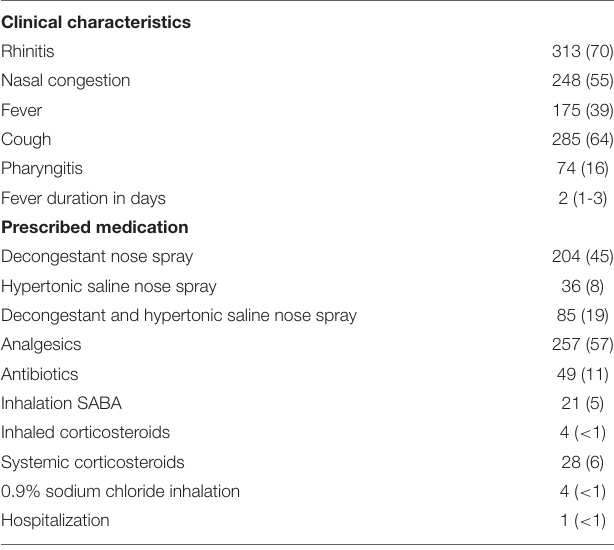
TABLE 2 | Clinical characterization and medication. Clinical